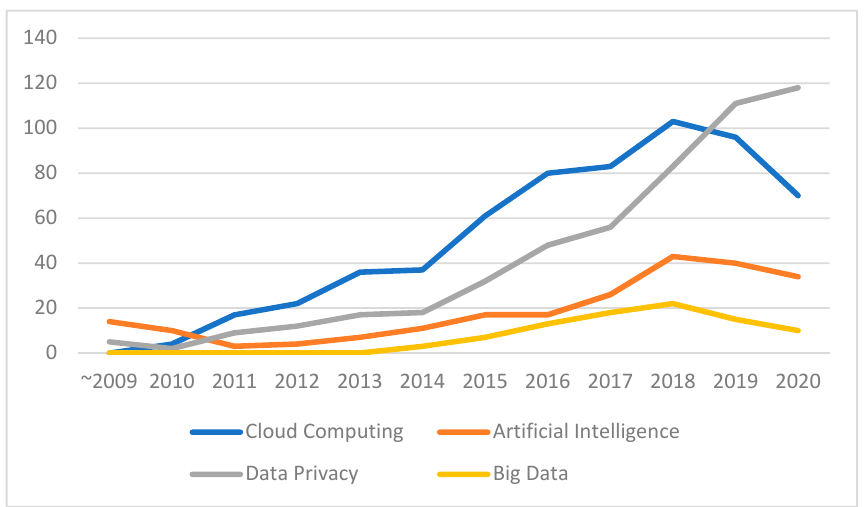
Figure 8. Annual number of papers published in the subfield.